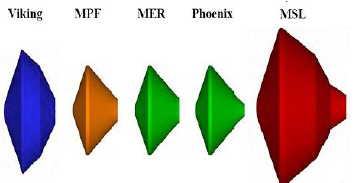
Figure 8. Different descent module configuration of NASA’s Mars missions